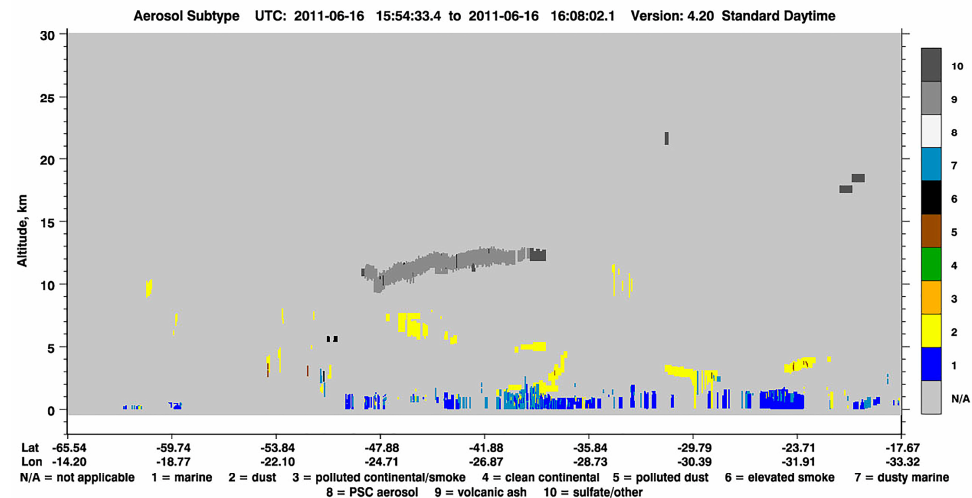
Figure 2. Image of CALIOP aerosol subtype from 15:54–16:08 UTC on 16 June 2011 for the Puyehue– Cordón Caulle eruption [37].